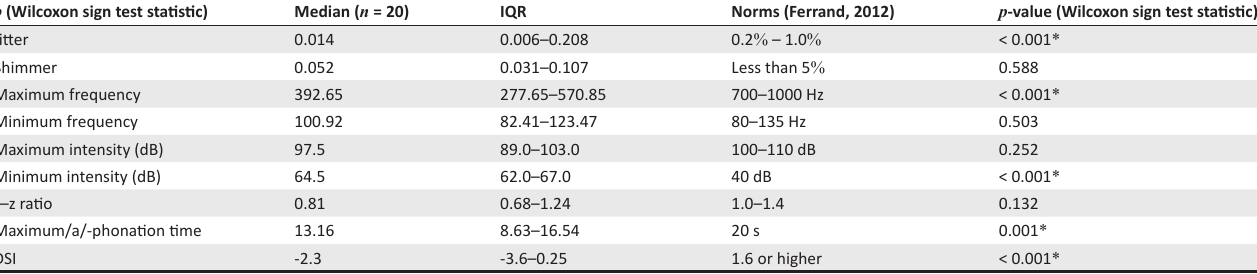
TABLE 4: Acoustic analysis: Descriptive statistics and